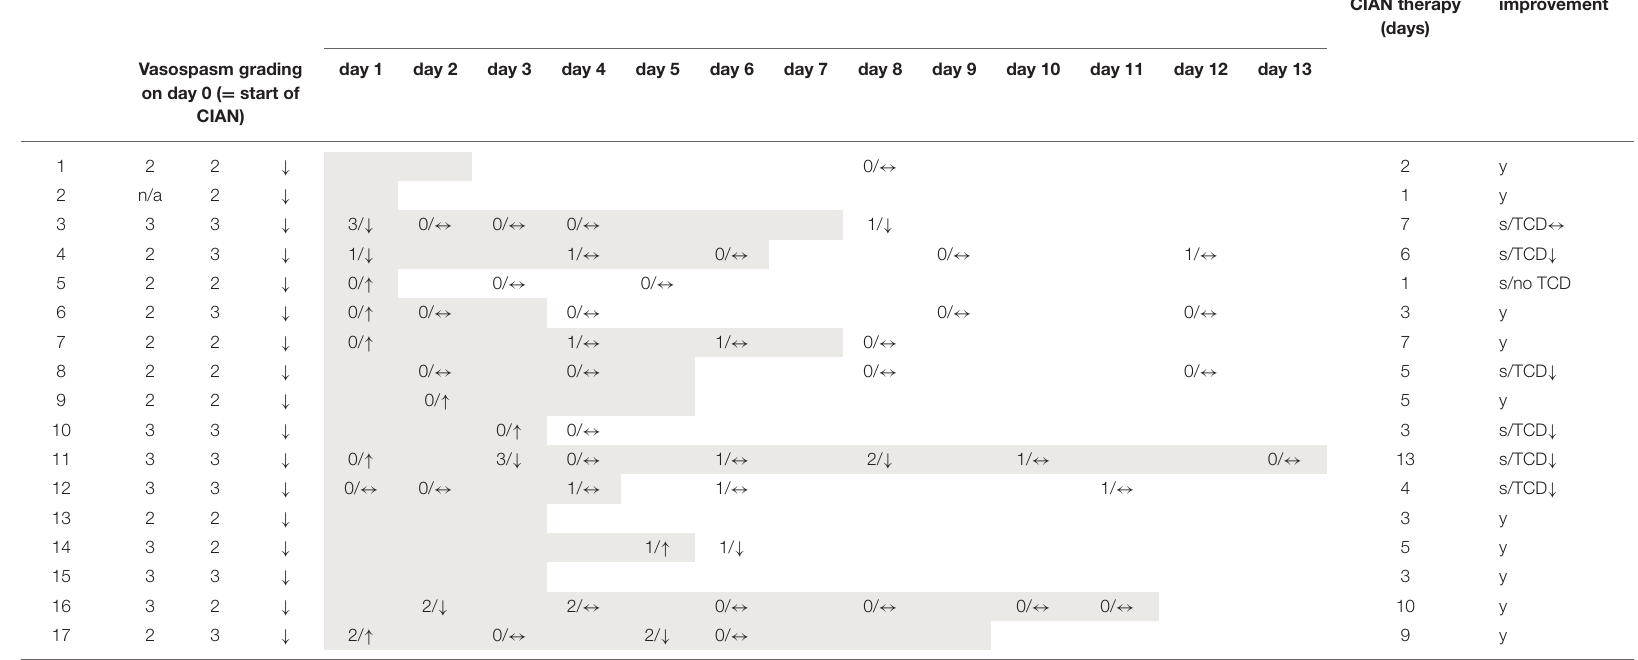
TABLE 2 | Treatment